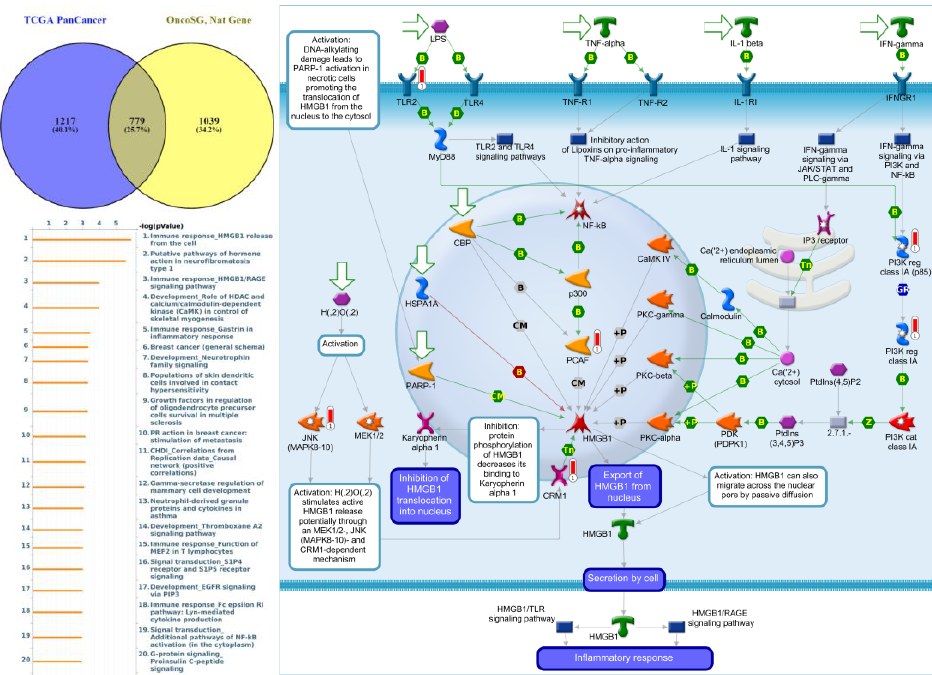
Figure 10. Expression of the protein tyrosine phosphatase non-receptor type 13 (PTPN13) signaling pathway in lung cancer (from Metacore). The functional analysis of “Immune response_HMGB1 release from the cell” was correlated with lung cancer development.